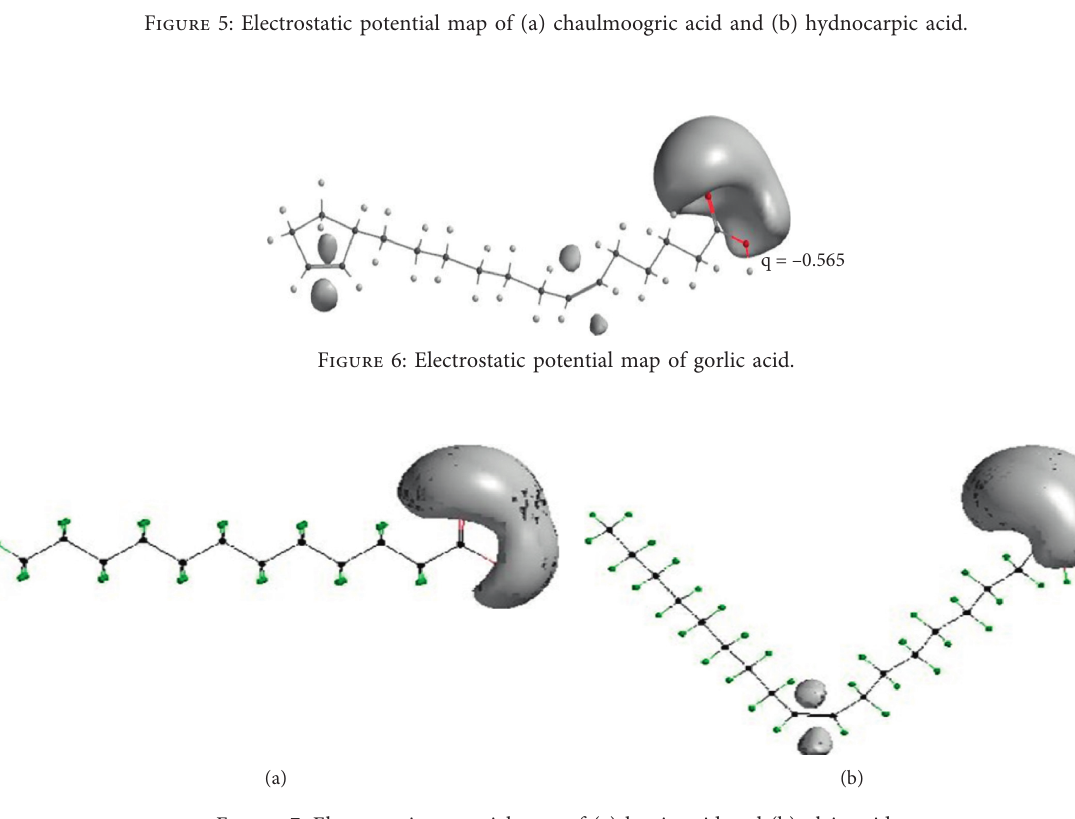
Figure 7: Electrostatic potential map of (a) lauric acid and (b) oleic